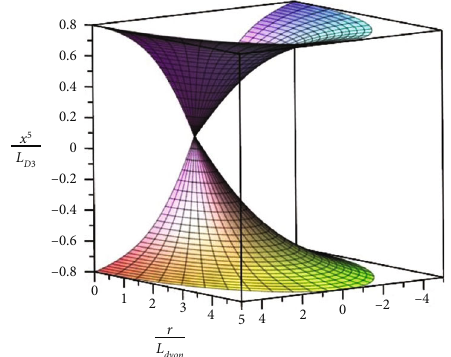
Figure 1: Wormhole. Shown is the embedding diagram of the two D 3 -branes with azimuthal angle suppressed. The radial coordinate, , and r , has been replaced with the dimensionless coordinate r / L dyon the embedding coordinate x 5 has been replaced with the dimensionless coordinate x 5 / L D 3